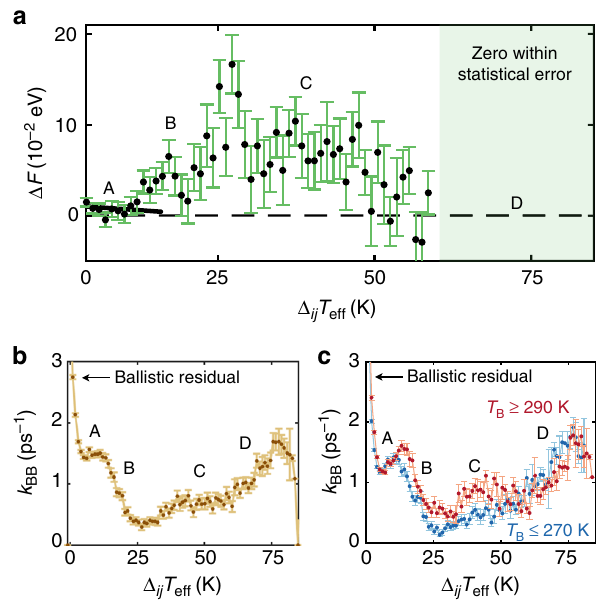
Fig. 4 Transport barriers and kinetic parameters. a Effective free energy barriers Δ F corresponding to different regions of the J BB fl ux pro fi le. Region A has nearly no barrier, but as the gradient becomes large, a barrier starts to form and increases in region B. In C, this barrier decreases until in D it is zero to within statistical error (albeit, the uncertainty is large in this last region due to the limited number of samples for large temperature gradients, which occur only at short times). b Backbone rate distributions ( k BB ) for helical Aib 10 conformers. Rate constants are parameterized by the temperature gradient Δ ij T eff between adjacent residues and c partitioned into low-temperature (blue; 230 – 270K) and high-temperature (red; 290 – 330 K) regimes. The error bars are plus/minus one standard